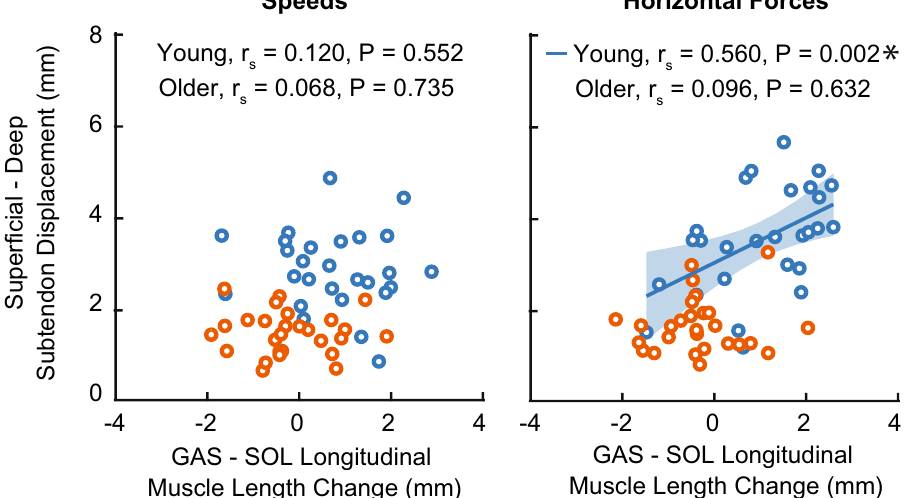
Figure 3. Spearman’s correlations between Achilles tendon non-uniformity (superficial—deep subtendon tissue displacements) and triceps surae muscle length change heterogeneity (i.e., medial gastrocnemius (GAS)–soleus (SOL) longitudinal muscle length changes) during conditions that alter speed (left) and horizontal force (right). Individual data points for young and older adults represented by blue and orange open circles, respectively. Single asterisks (*) represent significant correlations (P <